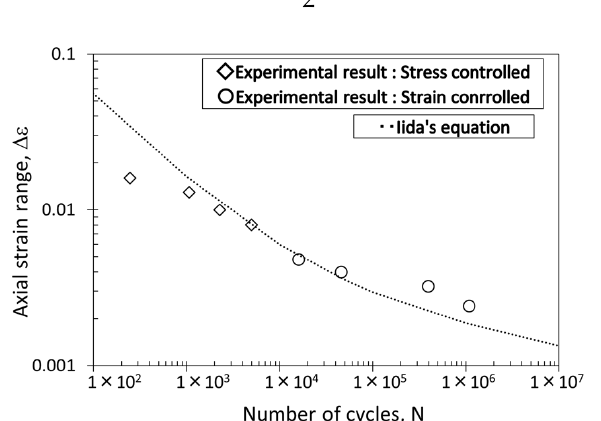
Figure 11. Relationships between strain range and fatigue crack initiation lives. Rhomboidal hollow markers indicate strain-controlled tests, whereas circular hollow markers indicate load-controlled tests. As can be seen from Figure 11, Iida’s prediction (cid:3047) (cid:3404) 0.415𝑁 (cid:3030)(cid:2879)(cid:2868).(cid:2874)(cid:2868)(cid:2874) (cid:3397) 0.00412𝑁 (cid:3030)(cid:2879)(cid:2868).(cid:2869)(cid:2869)(cid:2873) (1) 2 shows a good agreement with the experimental results obtained in this study. In general, it is well-known that strain range-based methods predict the fatigue (crack initiation) life well under constant amplitude loading conditions, as reported in previous works